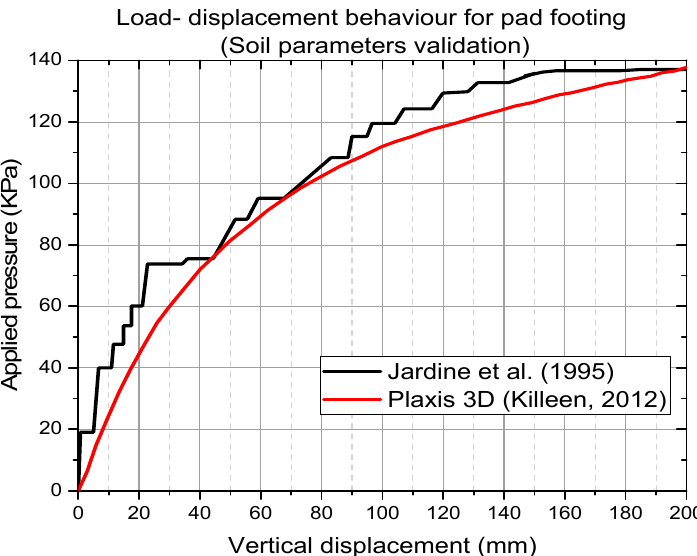
Figure 3. Validation of soil profile and parameters for a pad footing on untreated soft clay. Table 4. Measured [36] and predicted settlement for the field trials at the Bothkennar